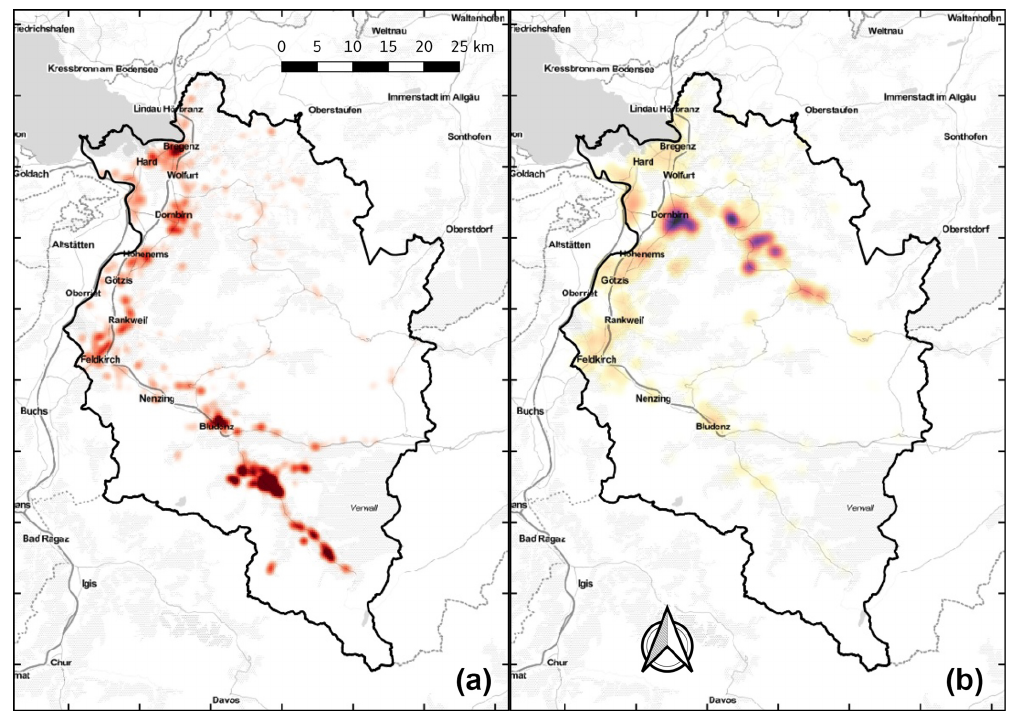
Figure 6. Spatial distributions of home locations of persons affected by incidents (based on the 30% sample). (a) Home location density of affected persons for incident 10 (darker means higher density). (b) Relative diversion time for incident 3 (delay over total daily travel time – cf. Fig. 5) inscribed at each person’s home location (darker means greater aggregated diversion